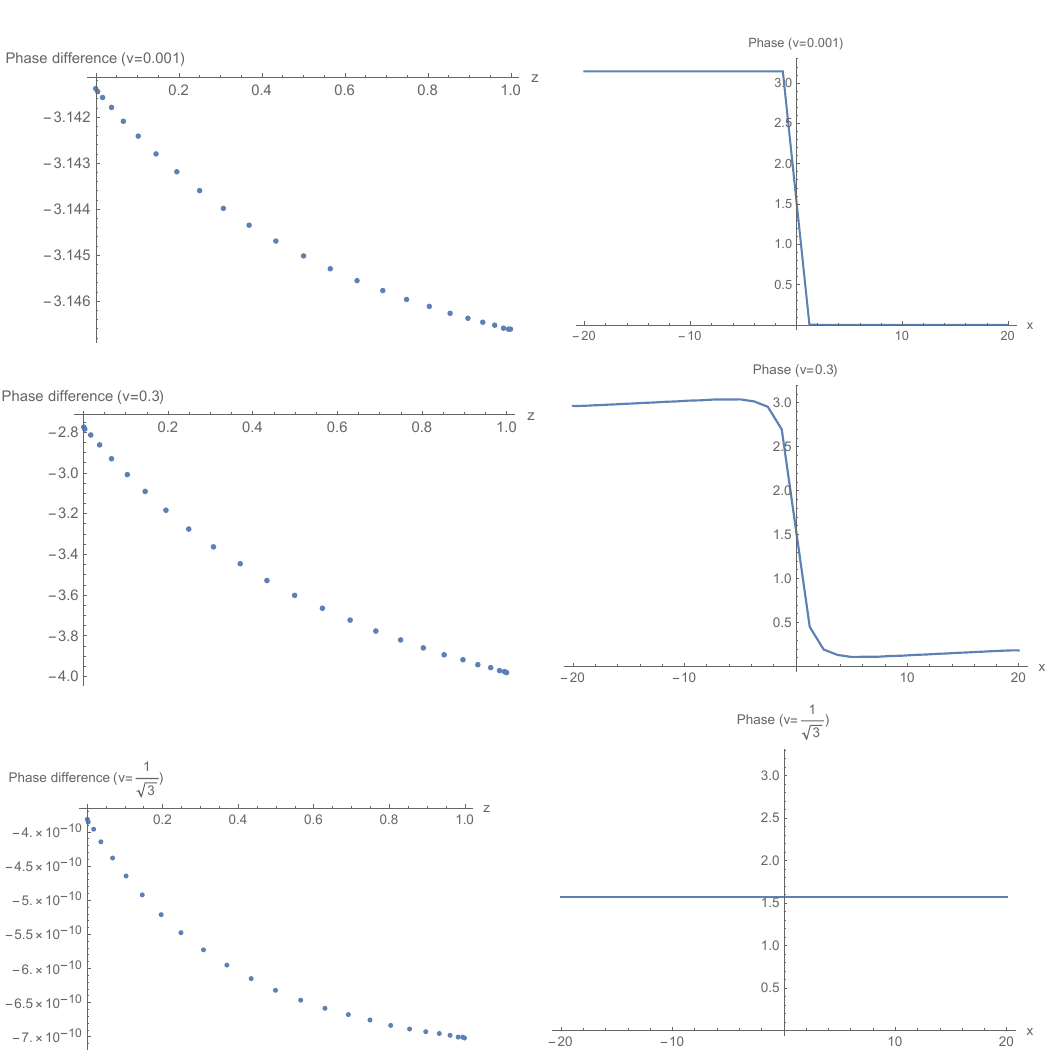
Figure 16 . The phase di(cid:11)erences and phase distributions for gray solitons at di(cid:11)erent speeds, under the alternative quantization with the chemical potential (cid:22) = 1 :